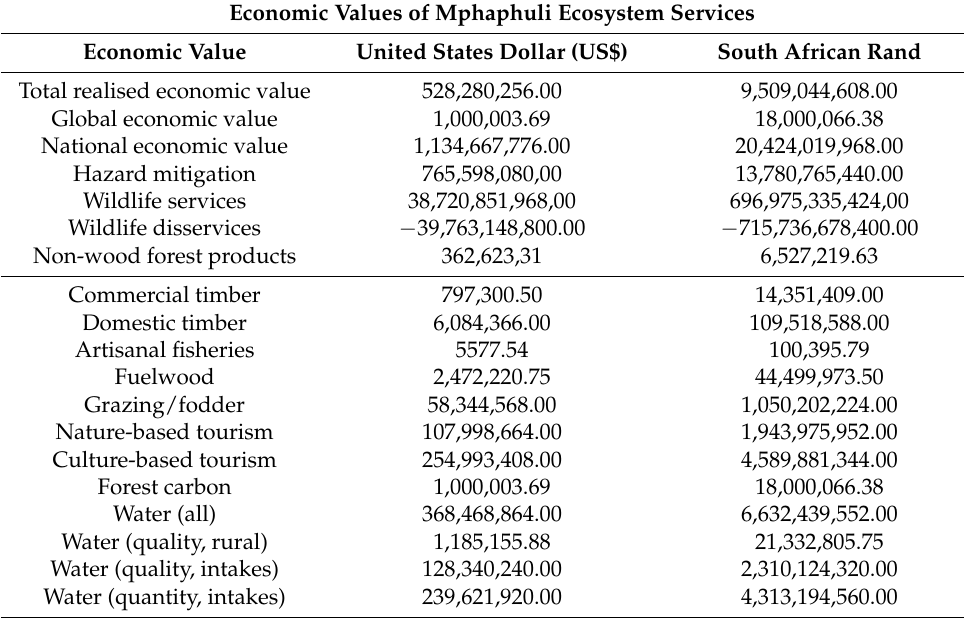
Table 3. The economic value of selected ecosystem